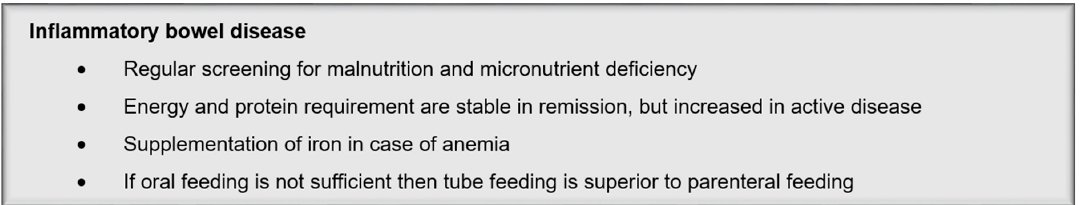
Figure 3. Summary of nutritional recommendations in inflammatory bowel disease.